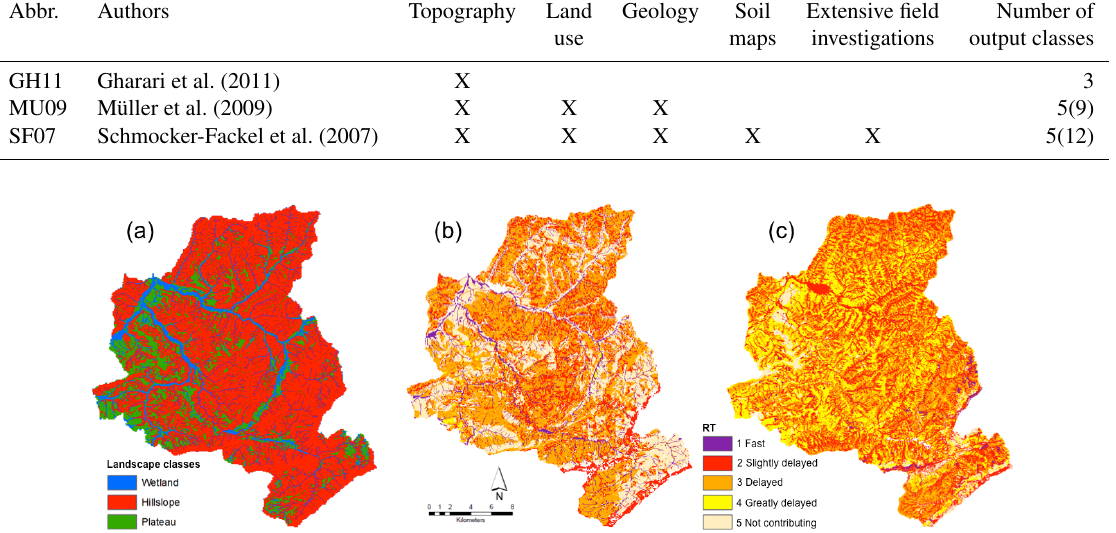
Table 1. List of the hydrological classifications used in this study, the data they require, the number of output classes used, and, in brackets, the number of output classes with the original approach. Adapted from Antonetti et al. (2016). Abbr.